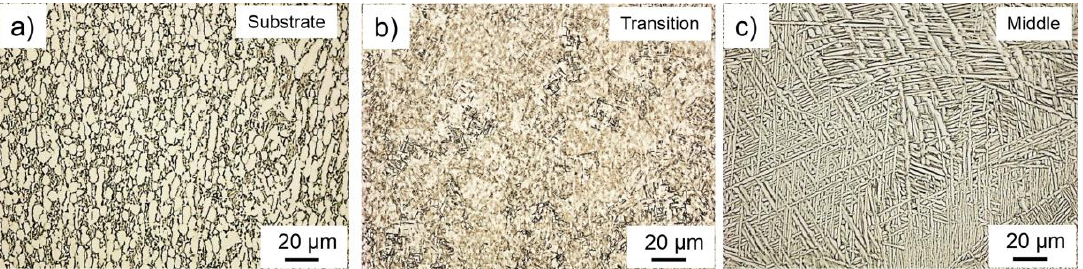
Figure 6. Typical micrographs obtained ( a ) in the substrate, ( b ) in the transition zone close to the substrate, ( c ) in the center of the WAAM part.